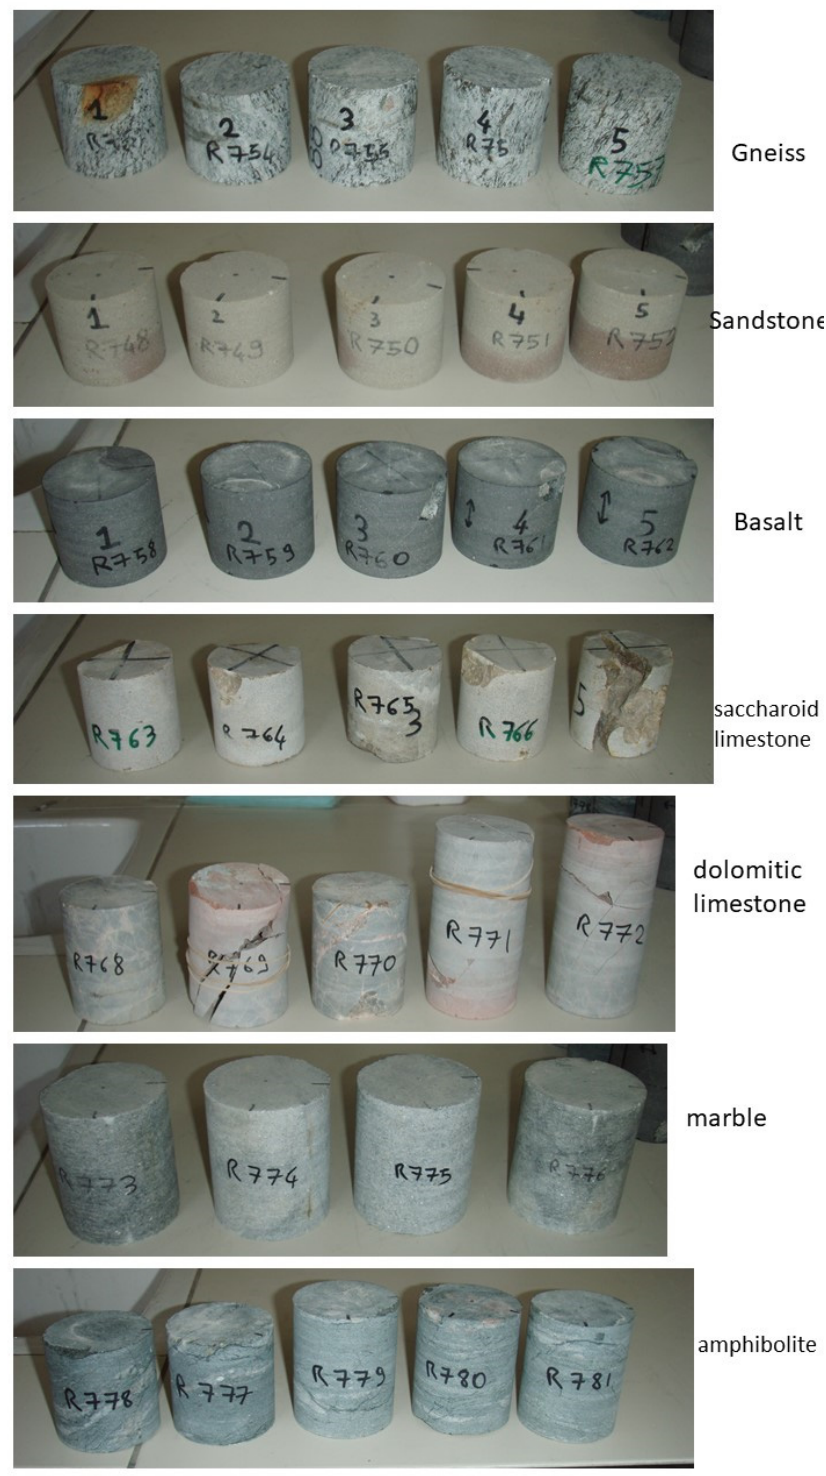
Figure 3. Samples at the end of experiments. From a macroscopic point of view, rocks react differently to FT cycles. Amphibolite samples are the most sensitive since all amphibolite samples broke between 14 and 28